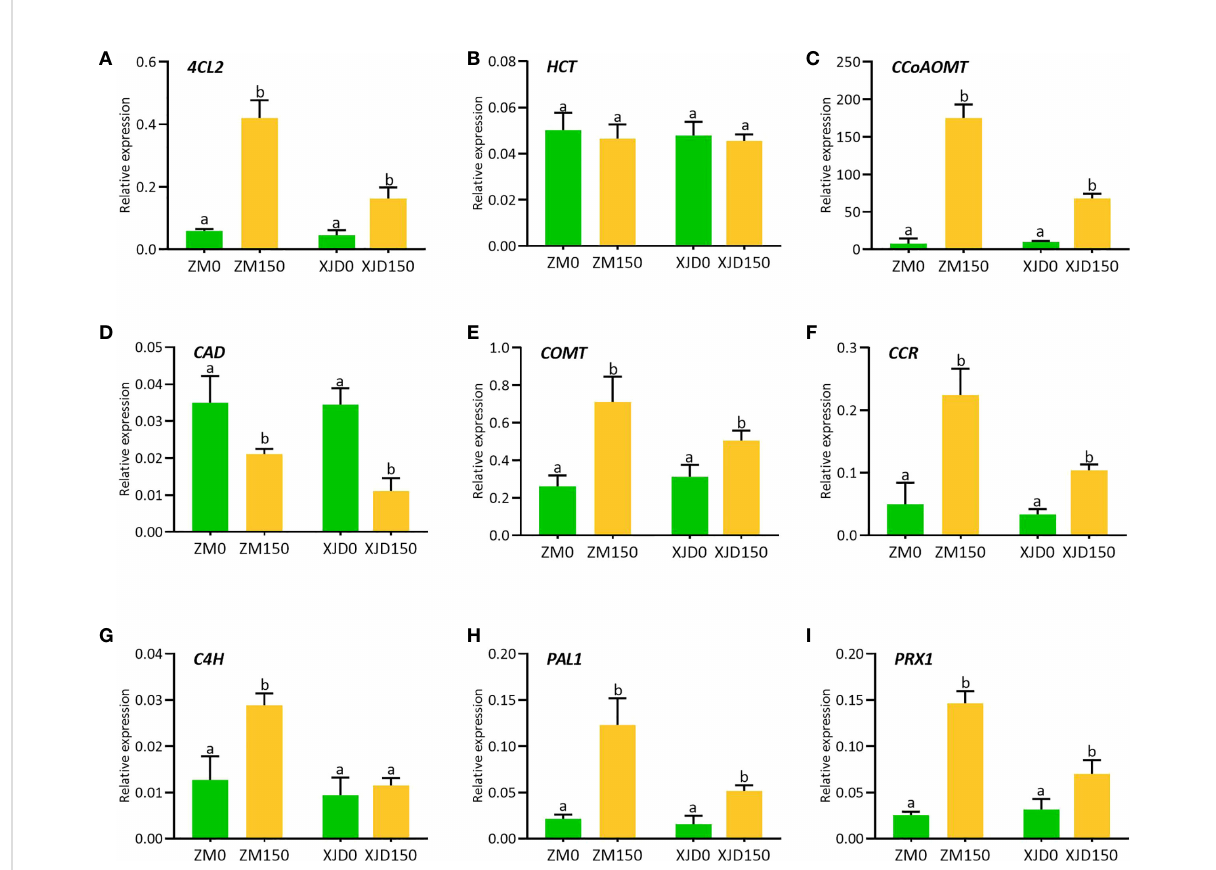
FIGURE 6 Transcript levels of various genes involved in lignin biosynthesis pathways as in fl uenced by salt stress in two contrasting alfalfa. Relative expression of 4CL2 (A) , HCT (B) , CCoAOMT (C) , CAD (D) , COMT (E) , CCR (F) , C4H (G) , PAL1 (H) , and PRX1 (I) in roots of Zhongmu (ZM) and Xingjiang Daye (XJD) under salt stress. MsActin gene was used to normalize the transcript abundance. The numeric zero (0) indicates salt- untreated (control) plant, while the numeric 150 indicates 150 mM salt treatment. Different letters above the column bar indicate signi fi cant differences among the means ± SD of treatments (n = 3). Data were analyzed by ANOVA and Tukey ’ s tests at p ≤ 0.05 signi fi cant